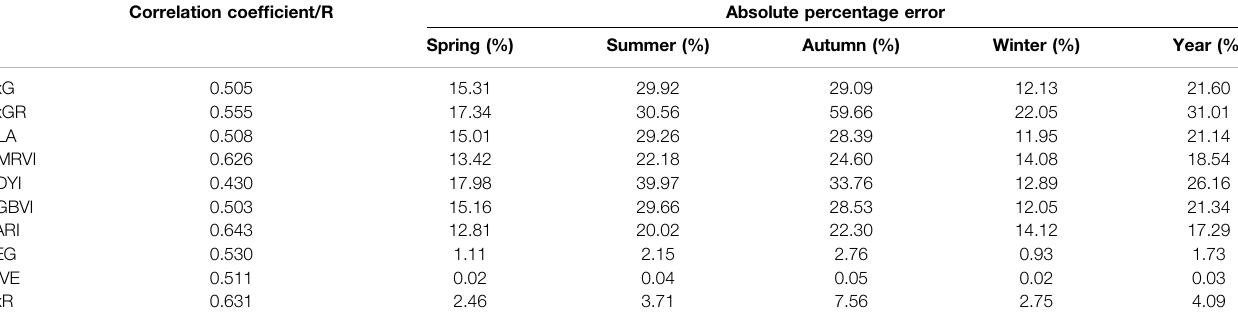
Daily minimum temperature